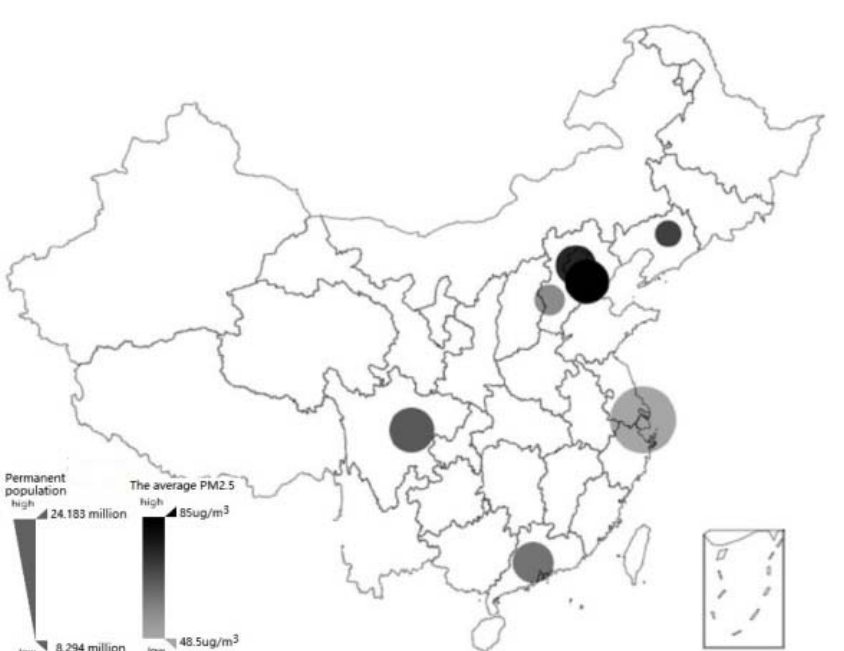
Figure 1. Sample distribution and the relative situation of the local permanent population and pollution in 2017. It shows the distribution of 7 cities at the provincial capital level and above among the sample cities in China. The circle area represents the relative proportion of the permanent population in the region, and the shading represents the relative value of the local average PM2.5 concentration in 2017.